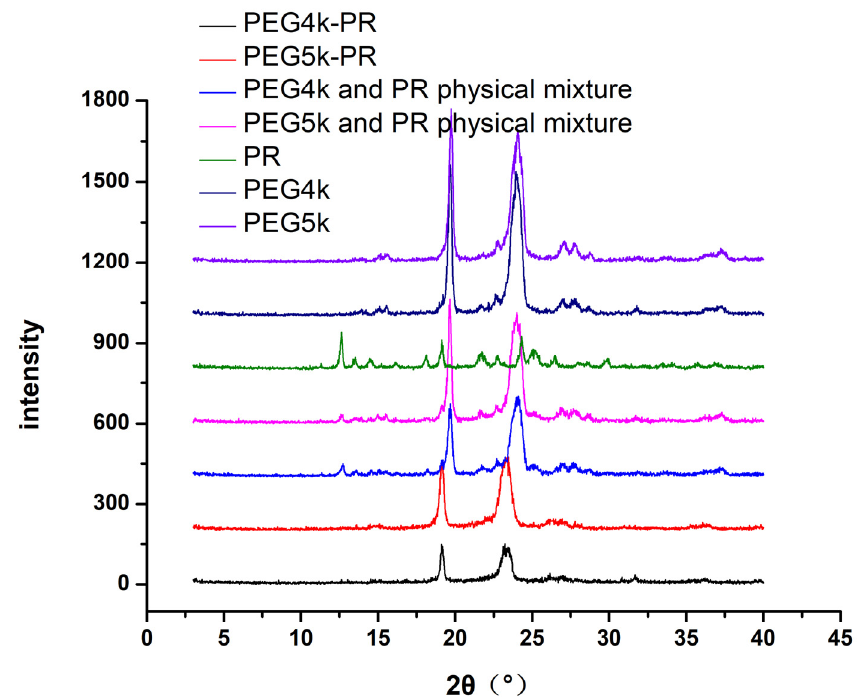
Figure 4. X-ray diffraction (XRD) spectra of PR, PEG4k/5k, PEG4k/5k-PR, and the physical mixtures of PEG4/5k and PR.